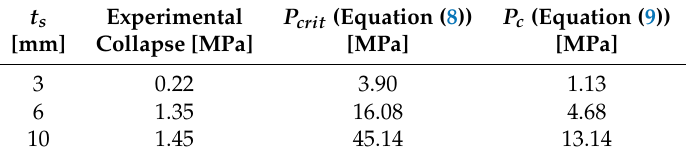
Table 7. Comparison between experimental and theoretical data found in the